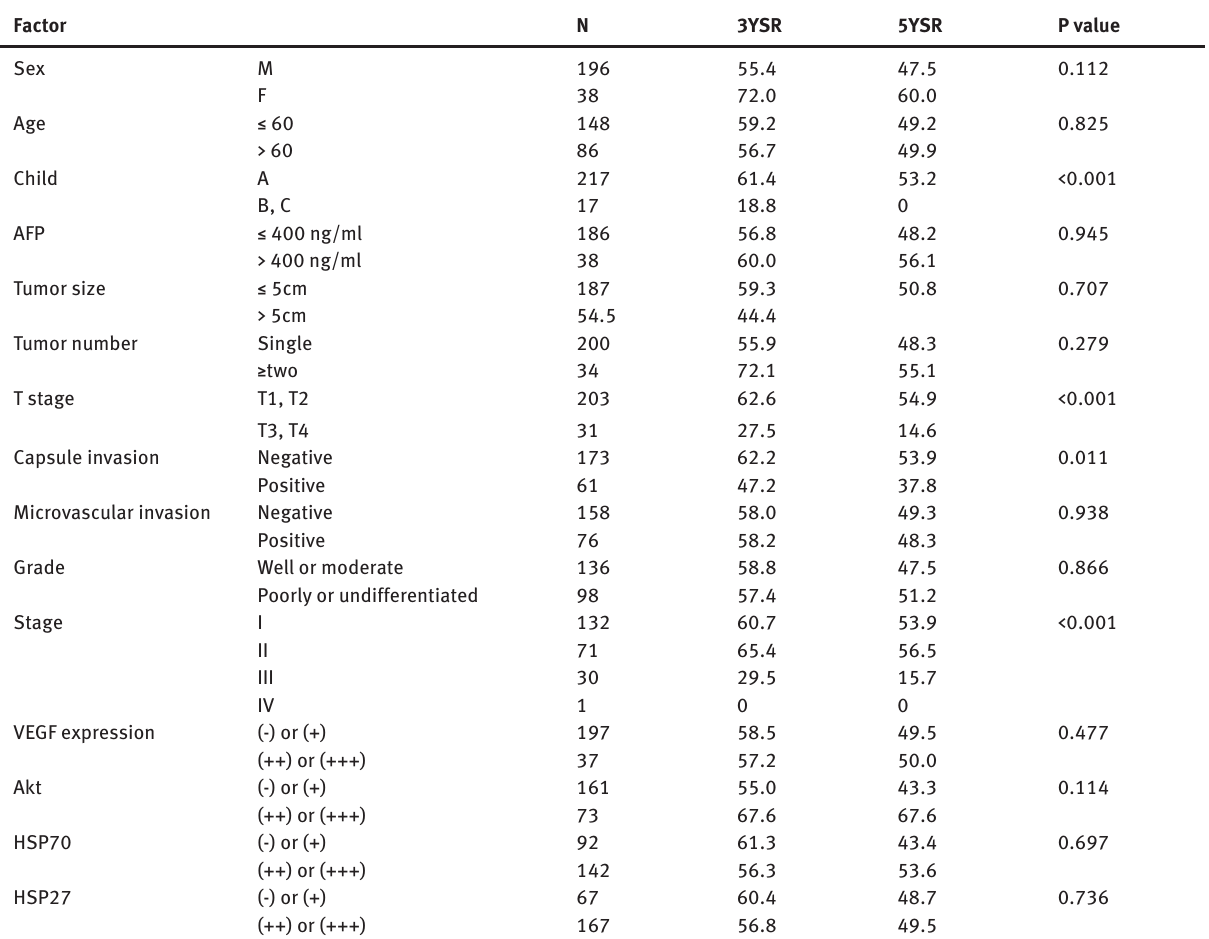
Table 4: Clinicopathological and immunohistochemical prognostic factors affecting on disease free survival